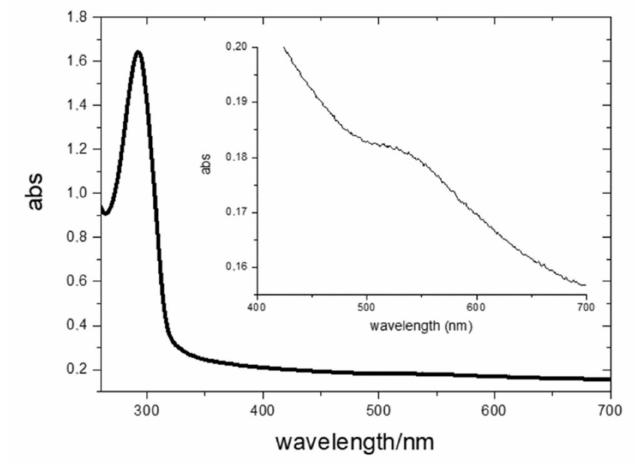
Figure 7. Absorption spectrum of Bpy-SH@AuNS in water